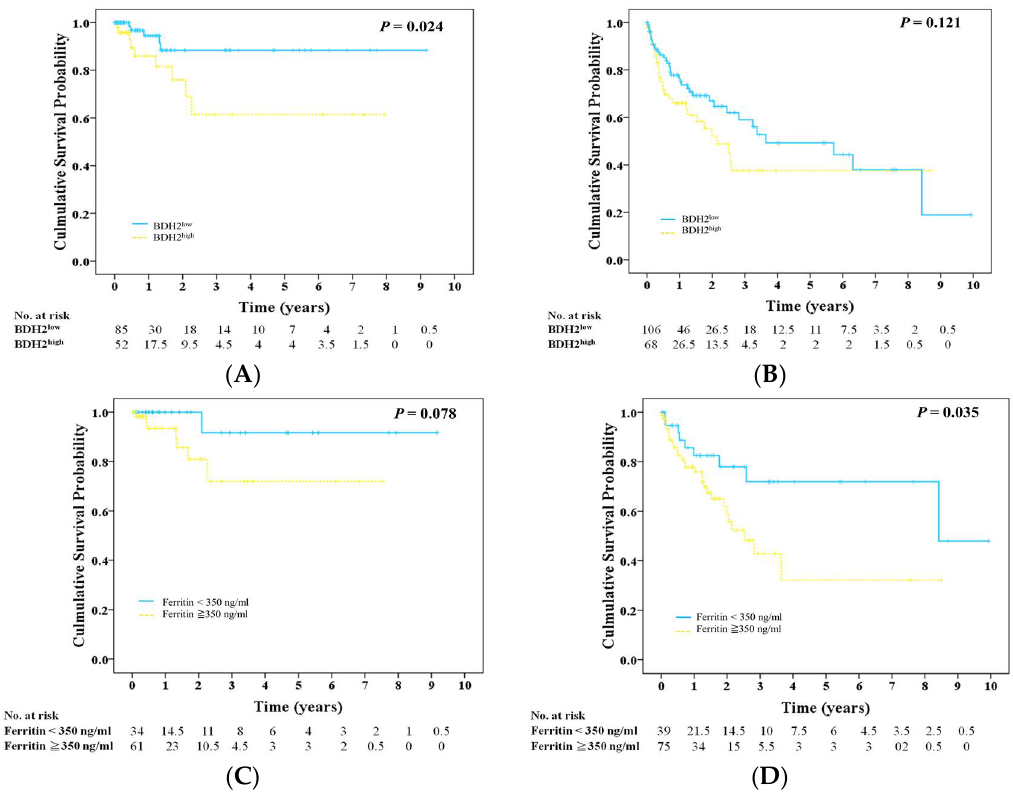
Figure 2. Survival rate in patients with MDS. ( A ) Leukemia-free survival and ( B ) overall survival in high and low BDH2 expression groups. ( C ) Leukemia-free survival and ( D ) overall survival in patients with ferritin level less than, equal to, or more than 350 ng/mL. BDH2, hydroxybutyrate dehydrogenase type 2.